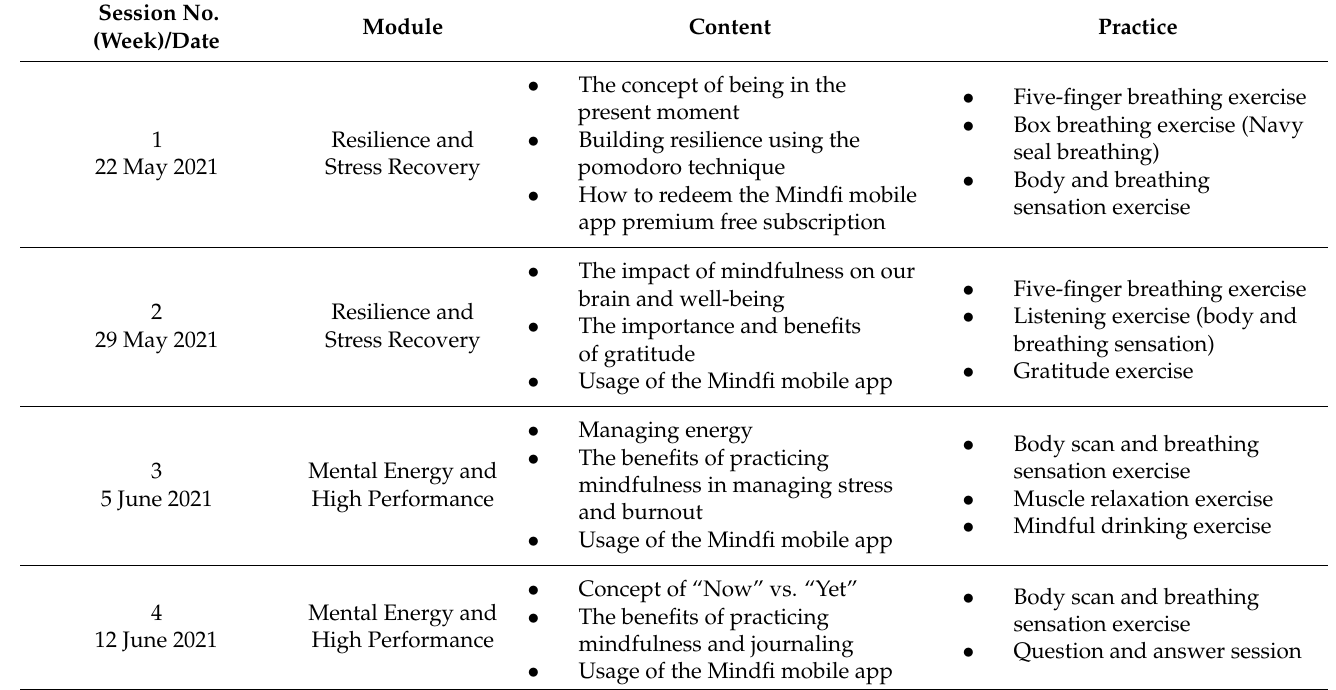
Table 1. Details of Corporate Wellness Program (Mindfulness Intervention Program) from 22